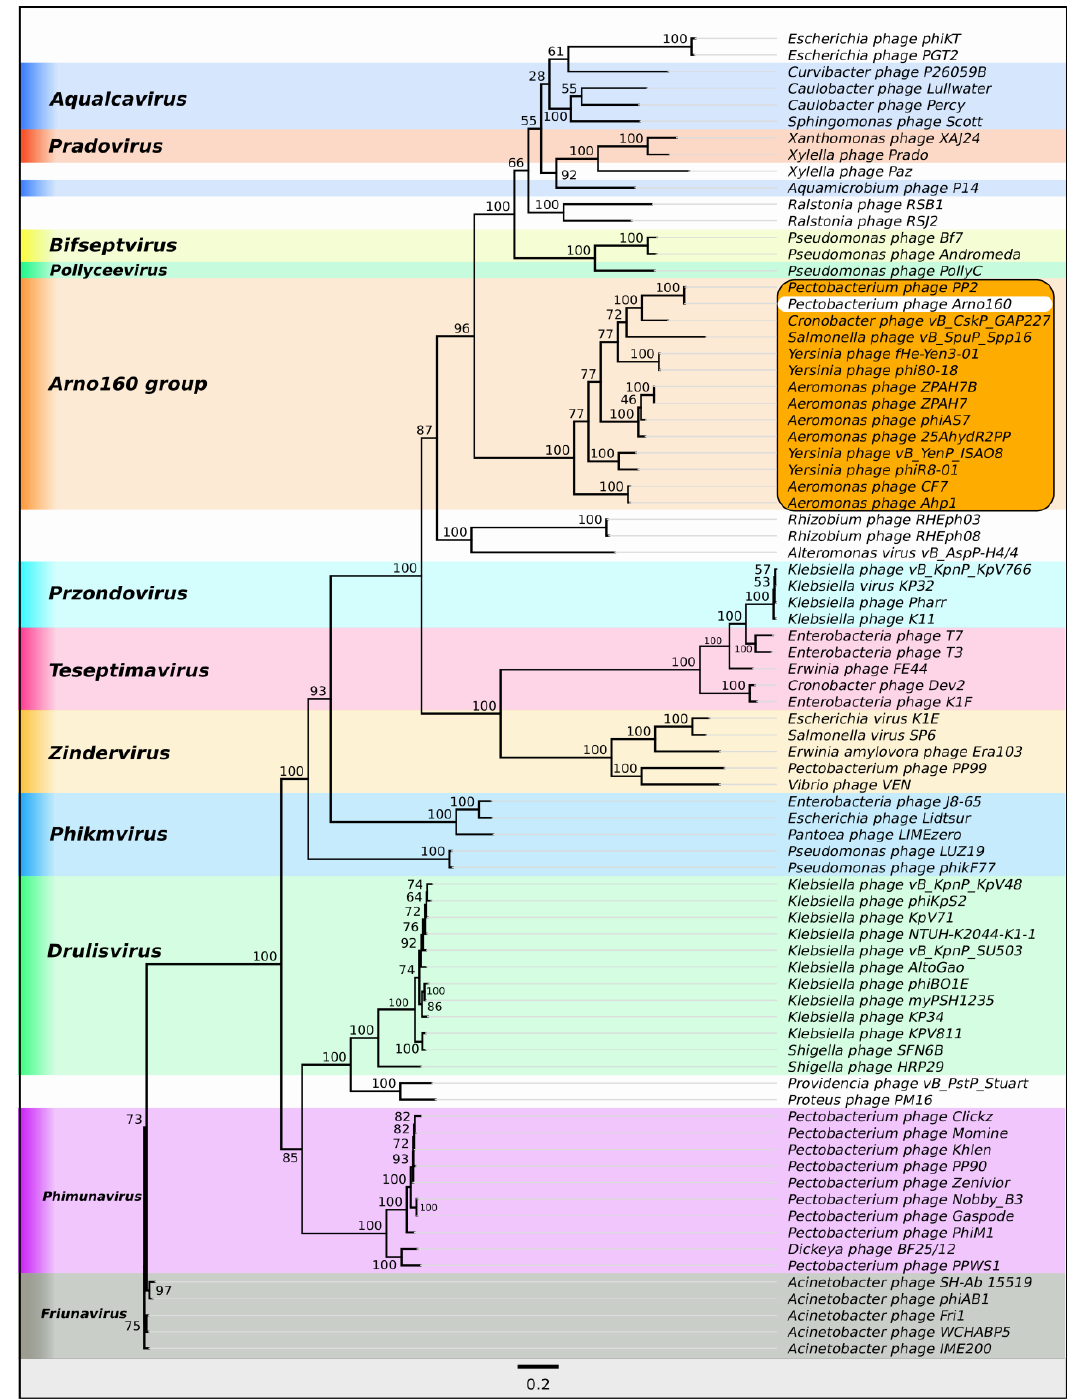
Figure 4. Phylogenetic tree of 80 concatenated amino sequences of phage DNA polymerase I, major capsid protein, DNA-directed RNA polymerase, head-to-tail connector protein and a large subunit of terminase (RAxML,GAMMA I BLOSSUM62 protein model, with 1000 bootstrap replicates).